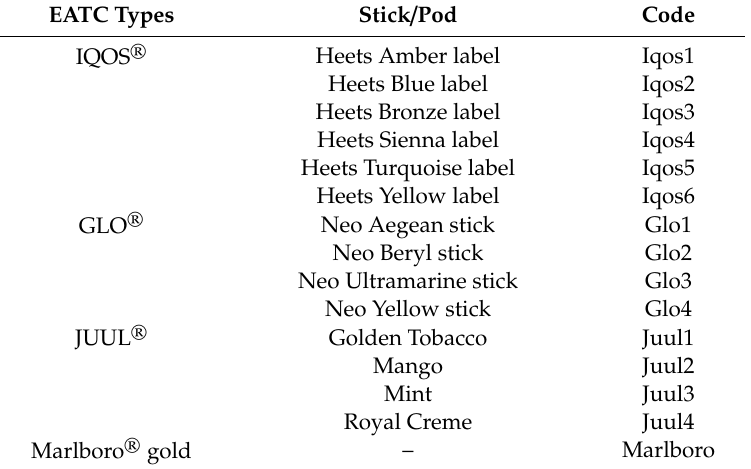
Table 1. Devices, flavors and relative codes of the